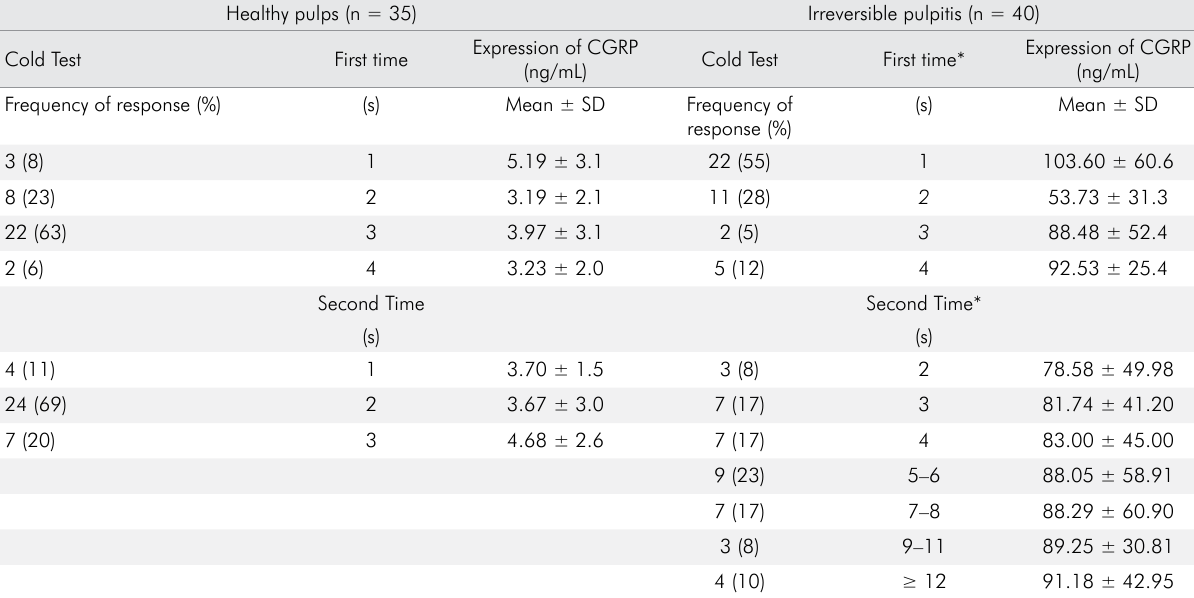
Table 3. Expression of CGRP and responses of cold test in healthy pulps and in irreversible pulpitis. Healthy pulps (n = 35)